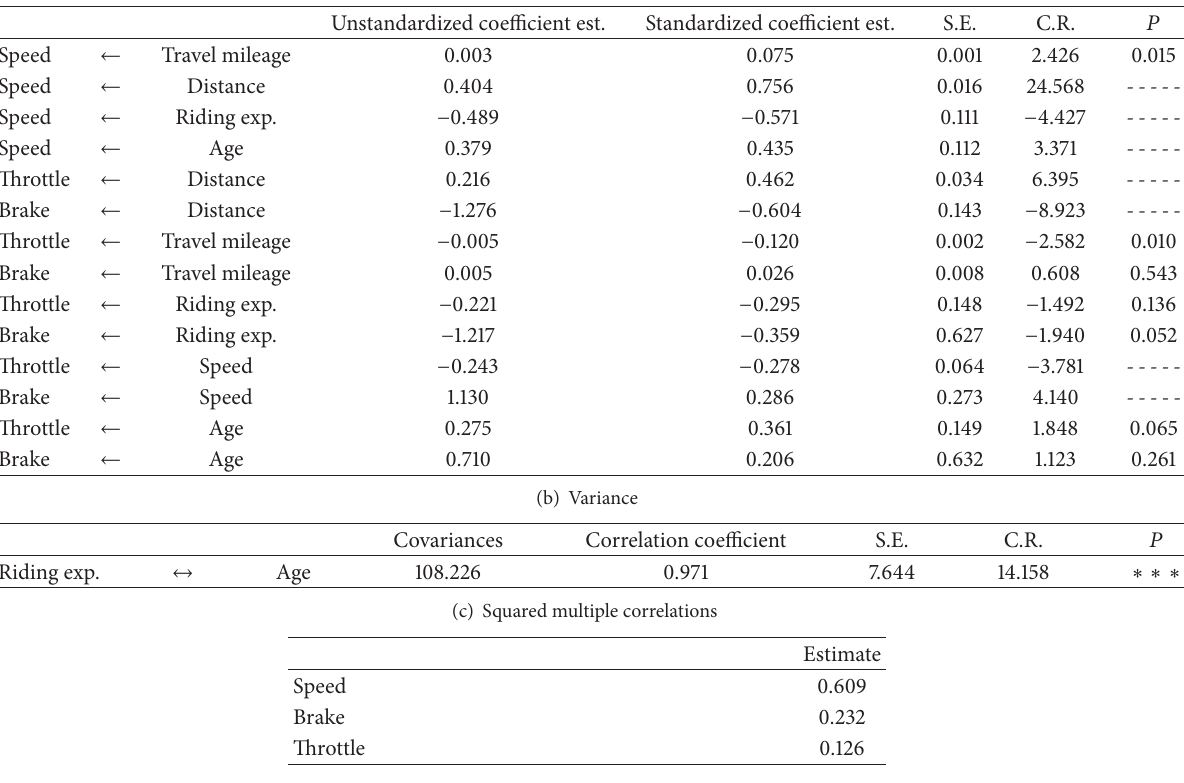
Table 6: Regression weights, standardized regression weights, variance, and squared multiple correlations. (a) Regression weights and standardized regression weights Unstandardized coefficient